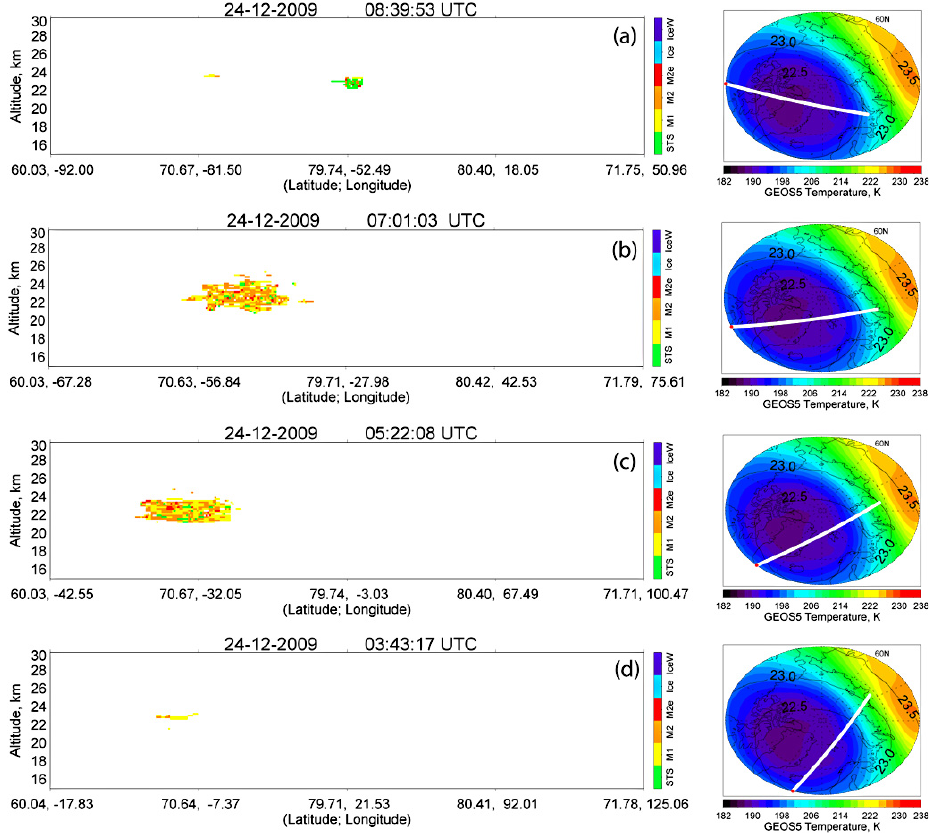
Fig. 12. Examples of CALIPSO PSC composition observations from four consecutive orbits during 24 December 2009. GEOS5 temperature and geopotential height fields at 30hPa for 12:00UTC are shown on the right with the location of the corresponding CALIPSO orbit tracks indicated by the white